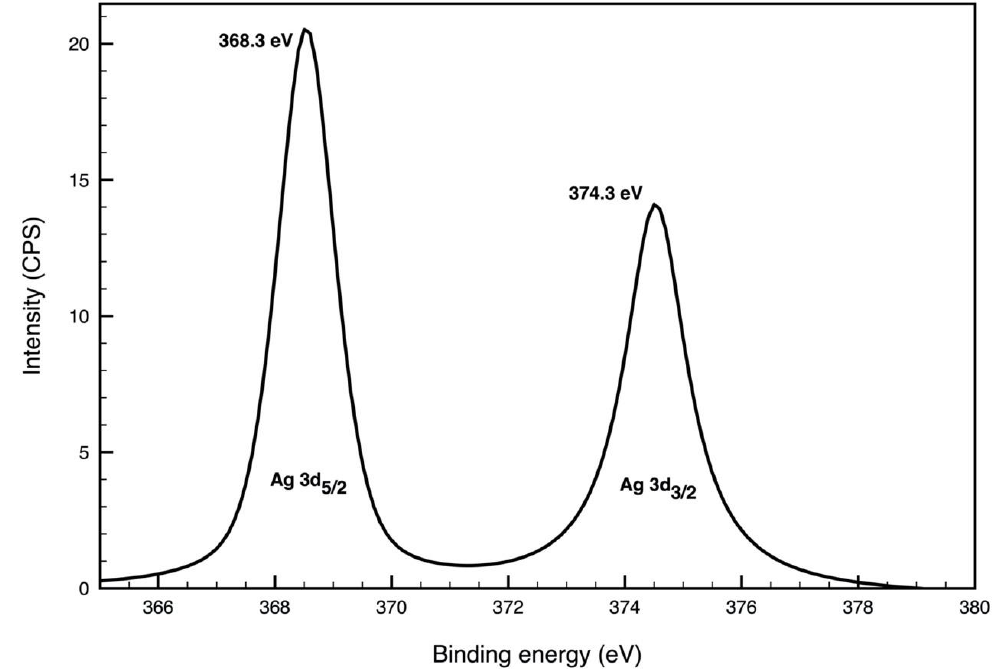
Figure 5. High-resolution XPS spectrum of the Ag3d envelope of plasma-treated PA nylon fabric with deposited AgNPs (PA + CH + Ag 0/100).